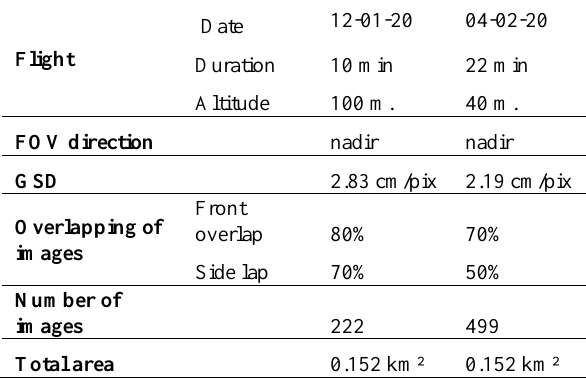
Table 1. Flight planning parameters for UAS data acquisition